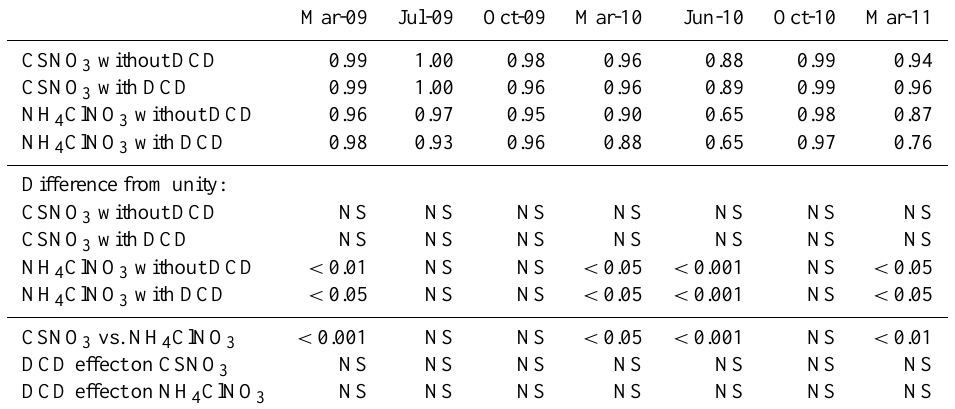
Table 4. The fraction of N 2 O derived from the labelled nitrate pool ( d D ) during peak N 2 O emissions for CSNO 3 and NH 4 ClNO 3 with and without